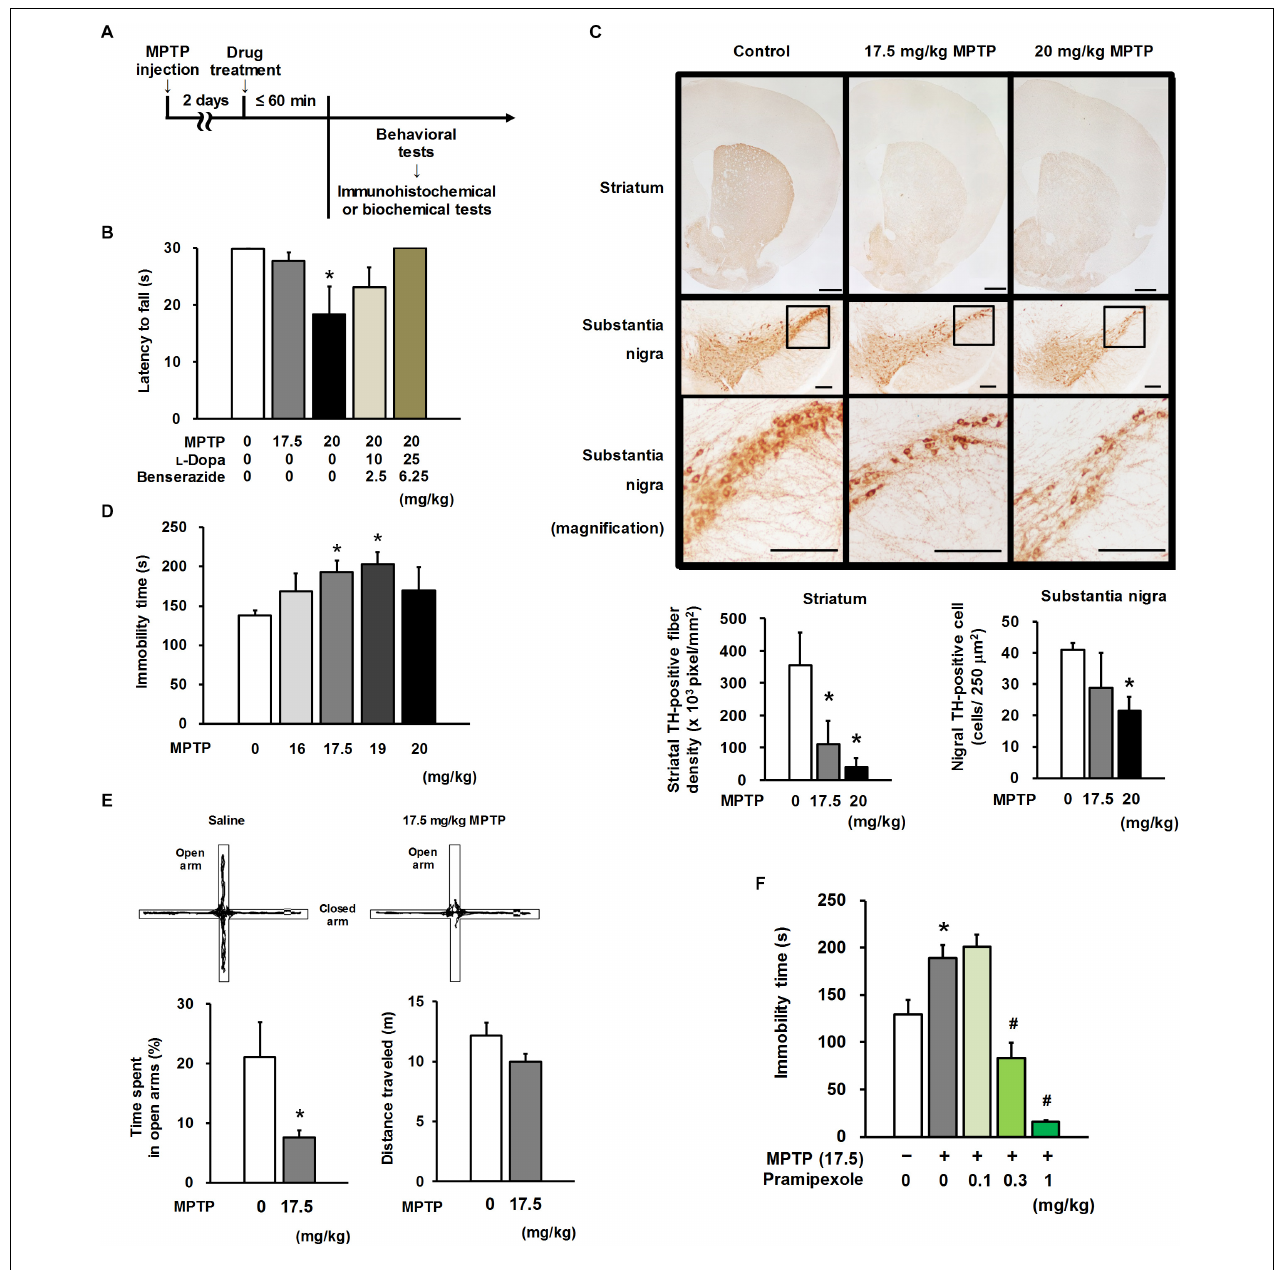
FIGURE 1 | Motor and non-motor characteristics in MPTP mice. (A) Experimental timeline. (B) Four repeated intraperitoneal injections of 1-methyl-4-phenyl-1,2,3,6-tetrahydropyridine (MPTP) at 20 mg/kg, but not 17.5 mg/kg, caused motor dysfunction in the horizontal bar test. Combined treatment with L -Dopa and benserazide (30 and 45 min before the behavioral test, respectively) ameliorated MPTP-induced motor dysfunction. The groups were control ( n = 13), 17.5 mg/kg MPTP ( n = 12), 20 mg/kg MPTP ( n = 5), 20 mg/kg MPTP + 10 mg/kg L -Dopa ( n = 5), and 20 mg/kg MPTP + 25 mg/kg L -Dopa ( n = 5). Values represent means ± SEM. ∗ p < 0.05 versus the control group (Dunn’s test using Bonferroni adjustment). (C) Representative photomicrographs of tyrosine hydroxylase (TH) immunohistochemistry in the striatum and substantia nigra of MPTP- or saline-treated mice (upper). Administration of MPTP significantly induced a reduction in TH-positive striatal nerve terminals (lower left) and TH-positive nigral cells (lower right). Scale bar = 500 µ m (striatum) and 200 µ m (substantia nigra). The groups were control ( n = 3–4), 17.5 mg/kg MPTP ( n = 4), and 20 mg/kg MPTP ( n = 3–4). Values represent means ± standard deviation (SD). ∗ p < 0.05 versus the control group (Dunnett’s test), striatum: F ( 2 , 9 ) = 20.325, p < 0.05; substantia nigra: F ( 2 , 7 ) = 5.040, p < 0.05. (D) MPTP mice exhibited depression-like behavior in the tail suspension test (TST). The groups were control ( n = 11), 16 mg/kg MPTP ( n = 5), 17.5 mg/kg MPTP ( n = 5), 19 mg/kg MPTP ( n = 4), and 20 mg/kg MPTP ( n = 4). Values represent means ± SEM. ∗ p < 0.05 versus the control group (Dunnett’s test), F ( 4 , 24 ) = 3.146, p < 0.05. (E) Representative traces of MPTP- or saline-treated mice in the elevated plus maze (EPM) test (upper). Anxiety-like behavior (lower left) and distance traveled (lower right) in the EPM test in MPTP mice. The groups were control ( n = 11) and 17.5 mg/kg MPTP ( n = 10). Values represent means ± SEM. ∗ p < 0.05 versus the control group (Welch’s t -test). (F) Pramipexole (PRX) was administered 60 min before the TST. PRX improved depression-like behavior in the TST in MPTP mice. The groups were control ( n =